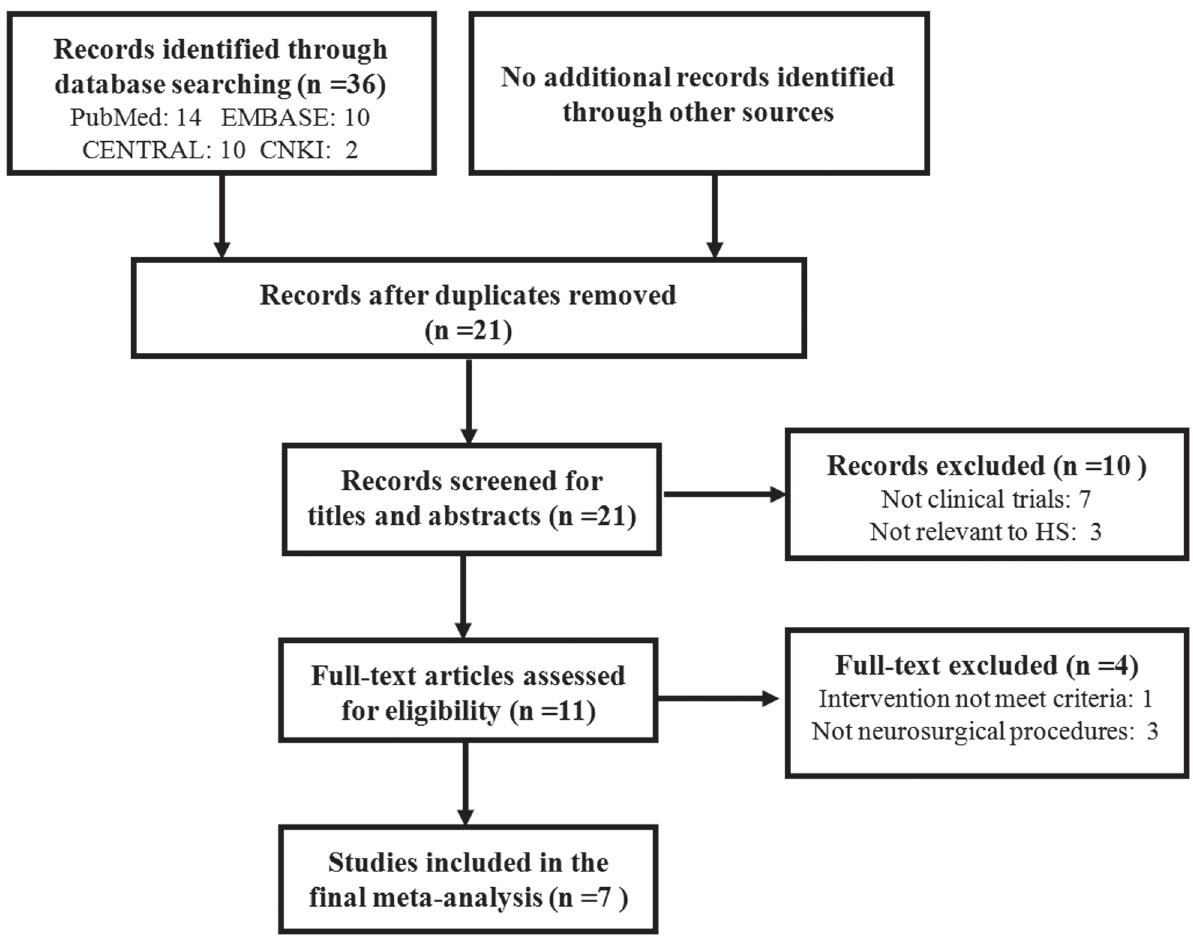
Fig 1. Flow chart of study selection in the present meta-analysis.